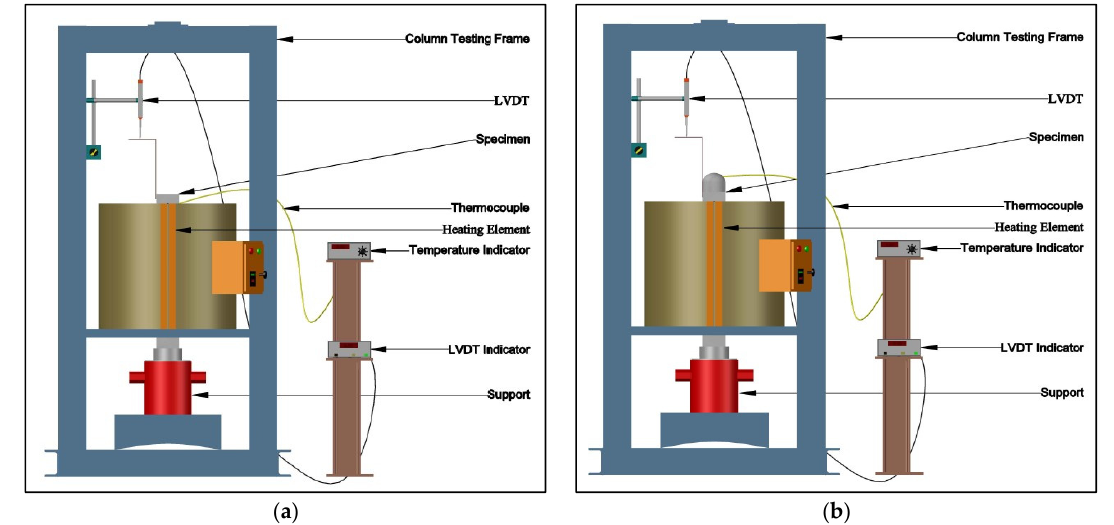
Figure 15. Schematic representation of test setup for ( a ) Conventional column. ( b ) Mimicked col- umn.